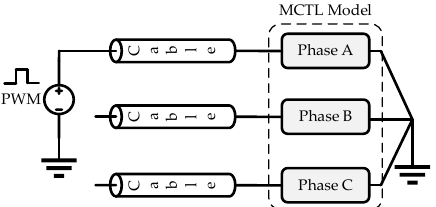
Figure 20. Three-phase model with grounded neutral point.